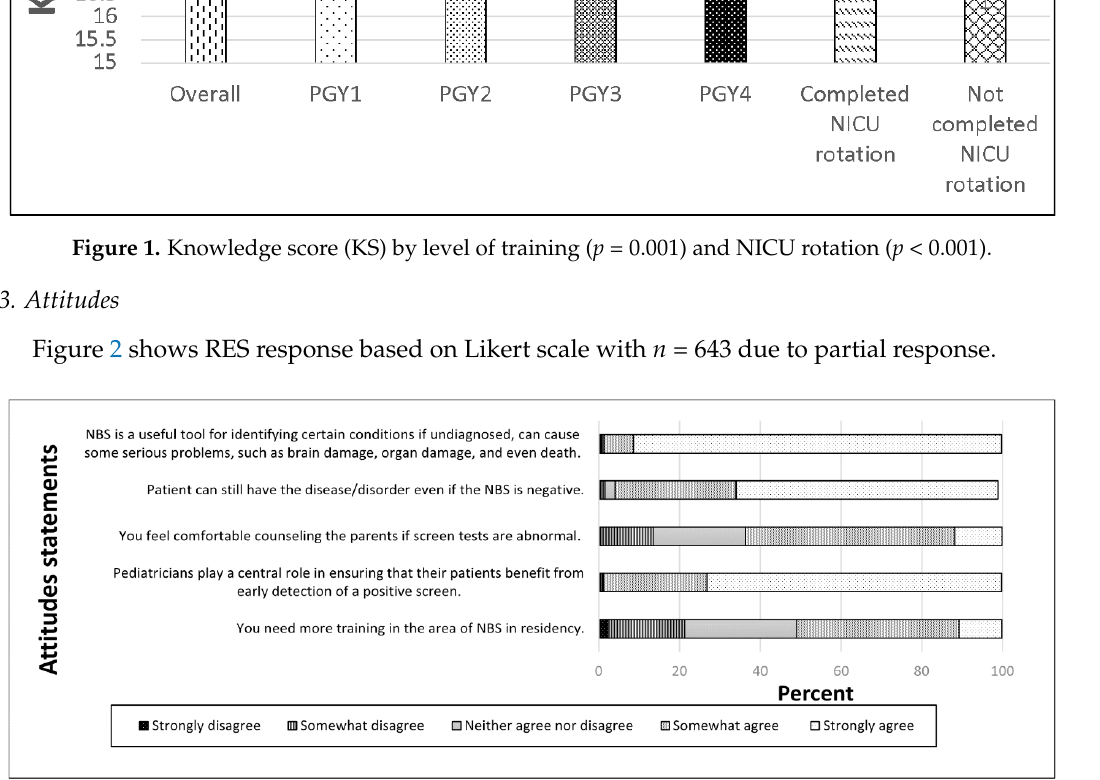
Figure 2. Responses to altitude questions ( n = 643 due to partial non-response).